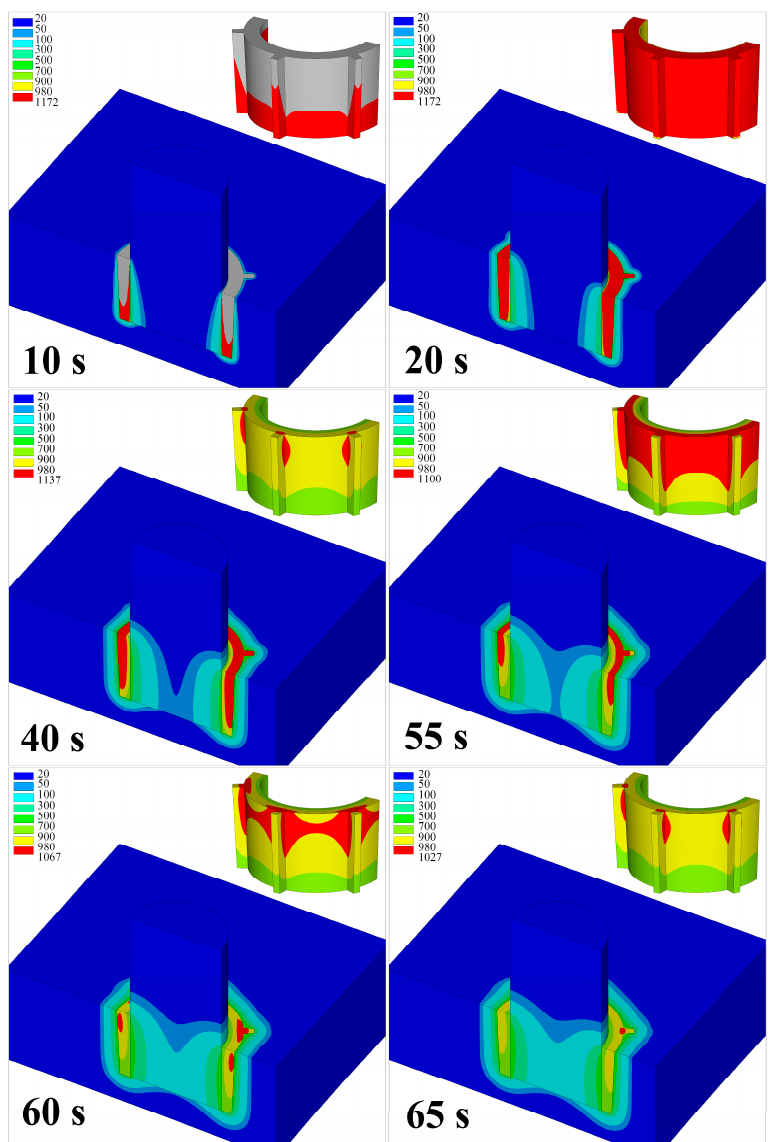
Figure 12. The temperature contours (°C) during solidification of the cast iron in the first stub hole. As shown in Figure 13, the percentage by volume of the solid zone, mushy zone, and liquid zone over time during solidification of the cast iron in the first stub hole were compared.